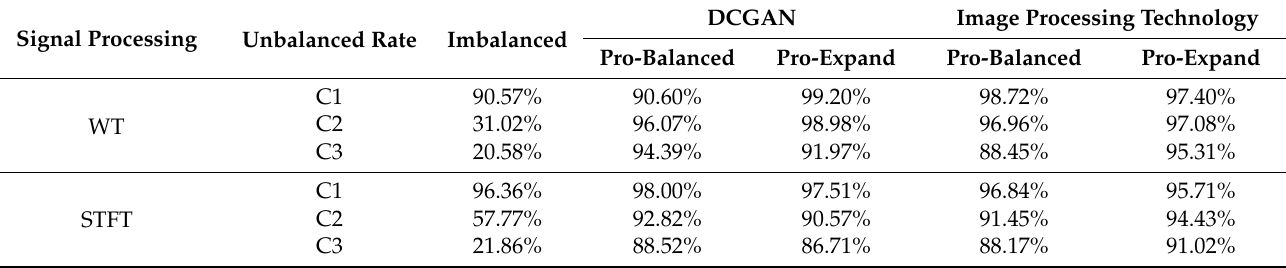
Table 11. Comparison of DCGAN and image processing